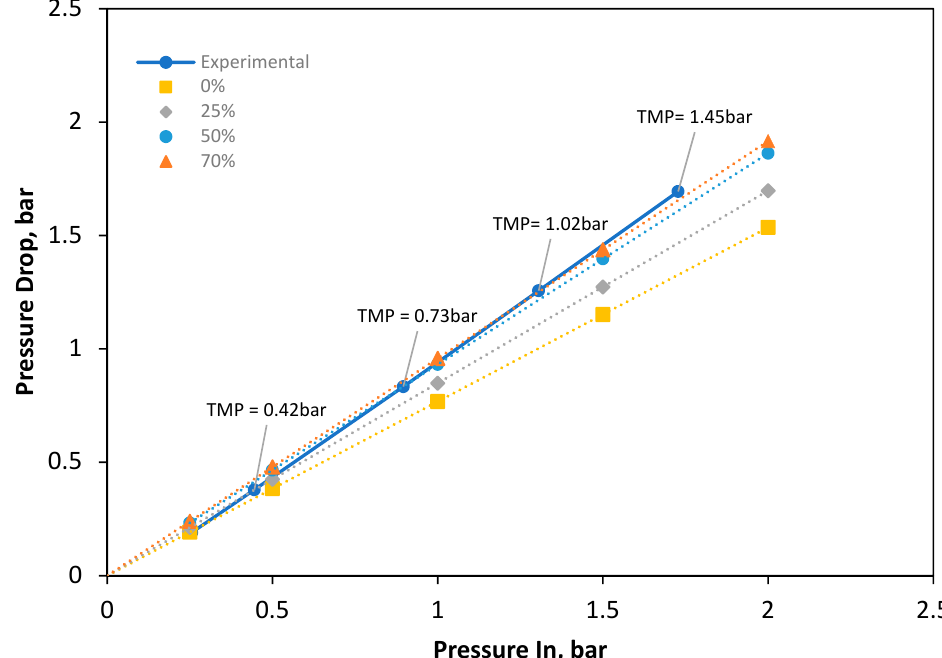
Figure 4. Inlet pressure plotted against pressure loss fit against experimentally collected data, ranging from 0–70% occlusion of membrane channel geometry by membrane occlusion.